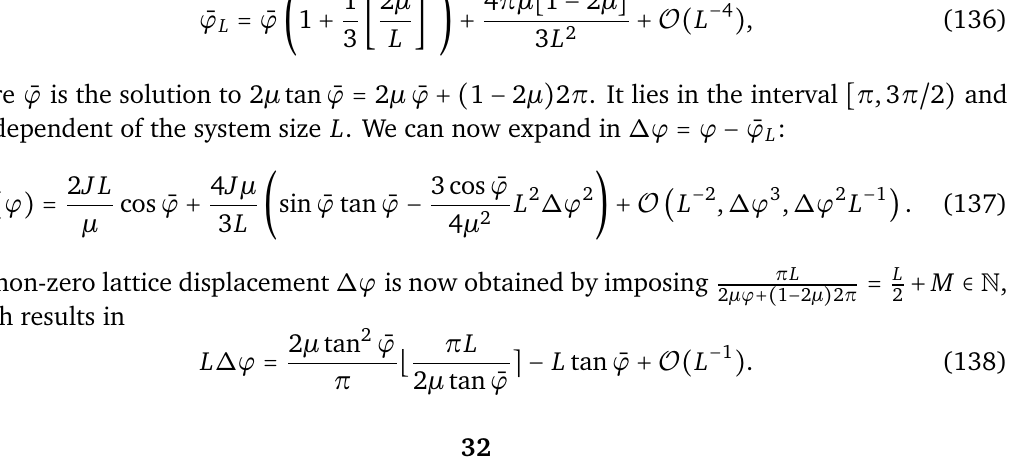
Figure 6: Energy per unit length (cid:34) = E / L and µ = M bols) in the low-energy part of the spectrum of ˜ H prediction (145), which is valid in the thermodynamic limit L → ∞